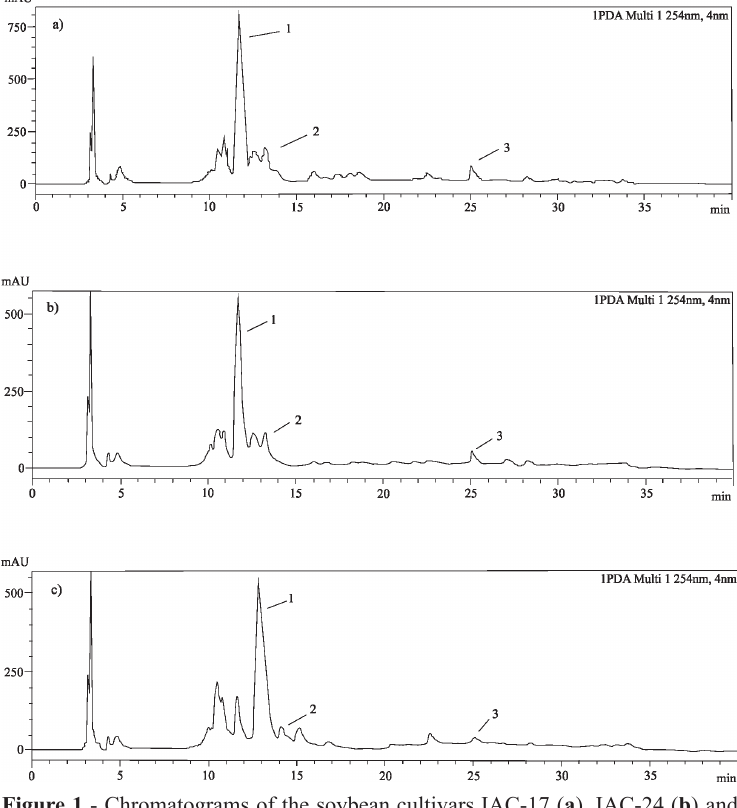
Figure 1 - Chromatograms of the soybean cultivars IAC-17 ( a ), IAC-24 ( b ) and IAC-PL1 ( c ) without mechanical damage. The daidzein compounds (1), retention time - RT 11.6 min, rutin (2), RT 13.7 min and quercetin (3), TR25 min were monitored under the chromatographic conditions flow 0.06 ml/min, 254 nm, column 4.5 x 15 cm (ODS - C 18), oven 40 °C, gradient phase ( a ) water acidified with acetic acid and ( b ) acetonitrile HPLC.